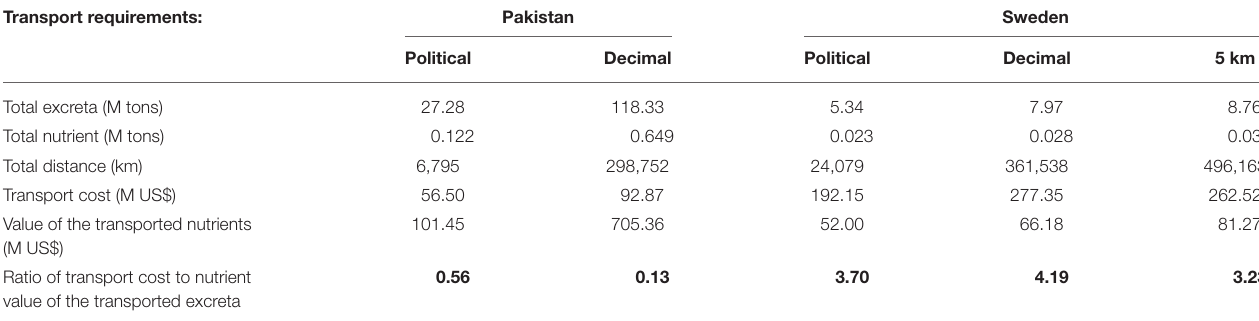
TABLE 3 | Total national weight, distance, and cost requirements associated with optimally transported surplus excreta at different resolutions in Pakistan and Sweden. Transport requirements: